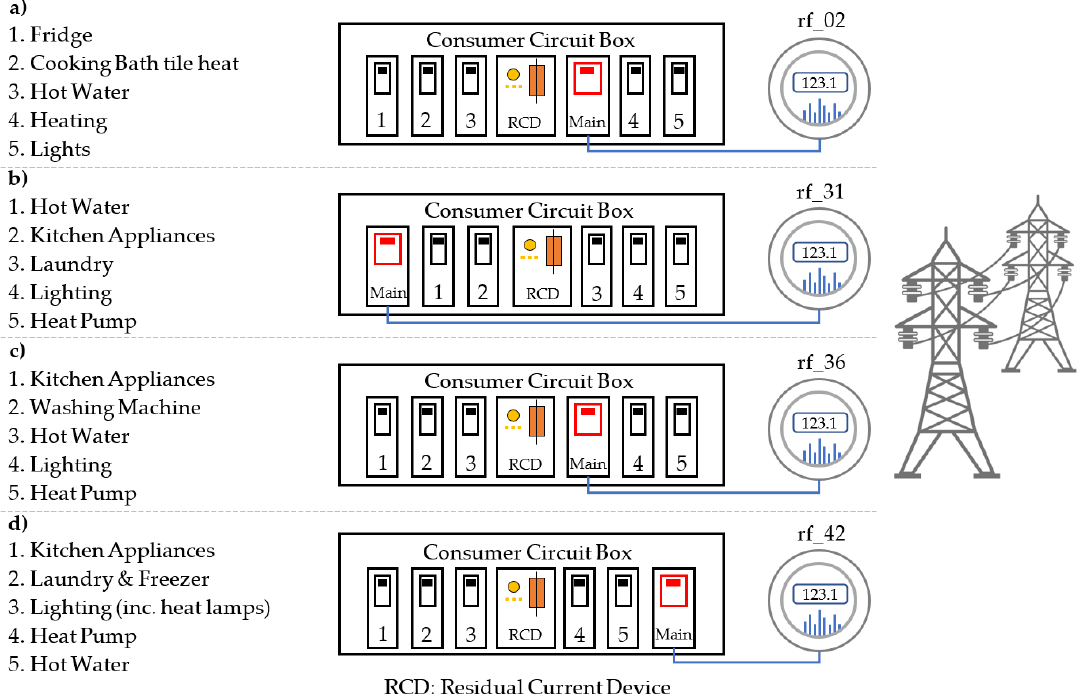
Table 5. Training and testing household data attributes and event detection results.